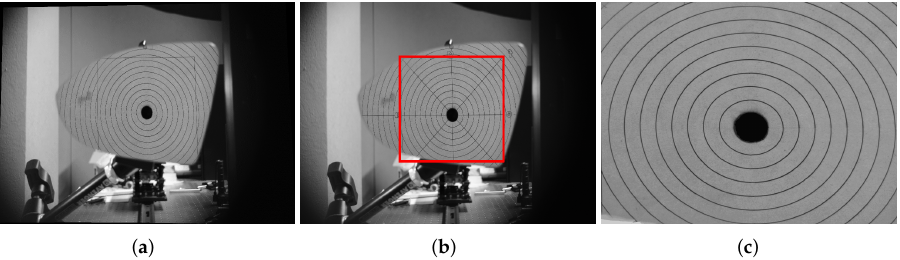
Figure 5. ROI selection and the resulting image. ( a ) Input image. ( b ) ROI selection. ( c ) Resulting image.